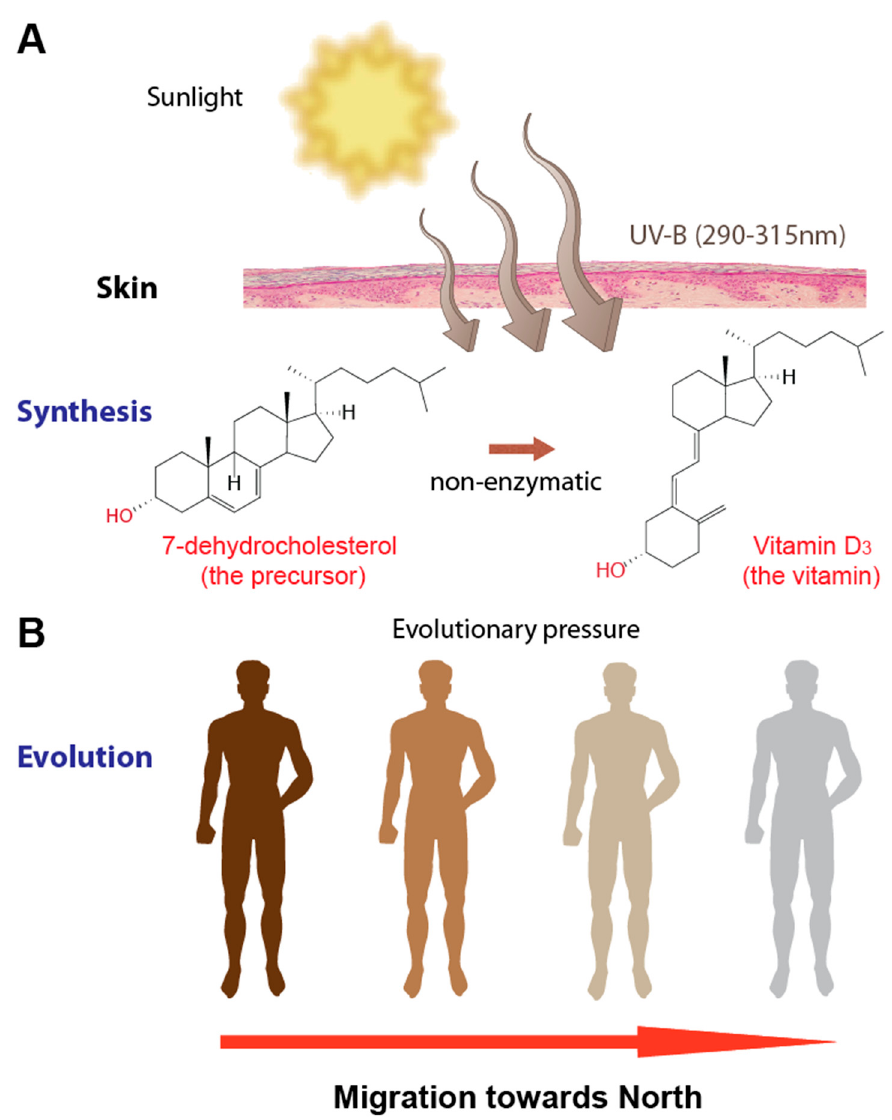
Figure 1. Vitamin D and human skin. Vitamin D 3 is synthesized endogenously in UV-B exposed human skin ( A ). During the past 10–30,000 years this essential need to synthesize vitamin D 3 was an evolutionary driver for skin lightening of modern humans migrating from Africa towards Europe and Asia ( B ).